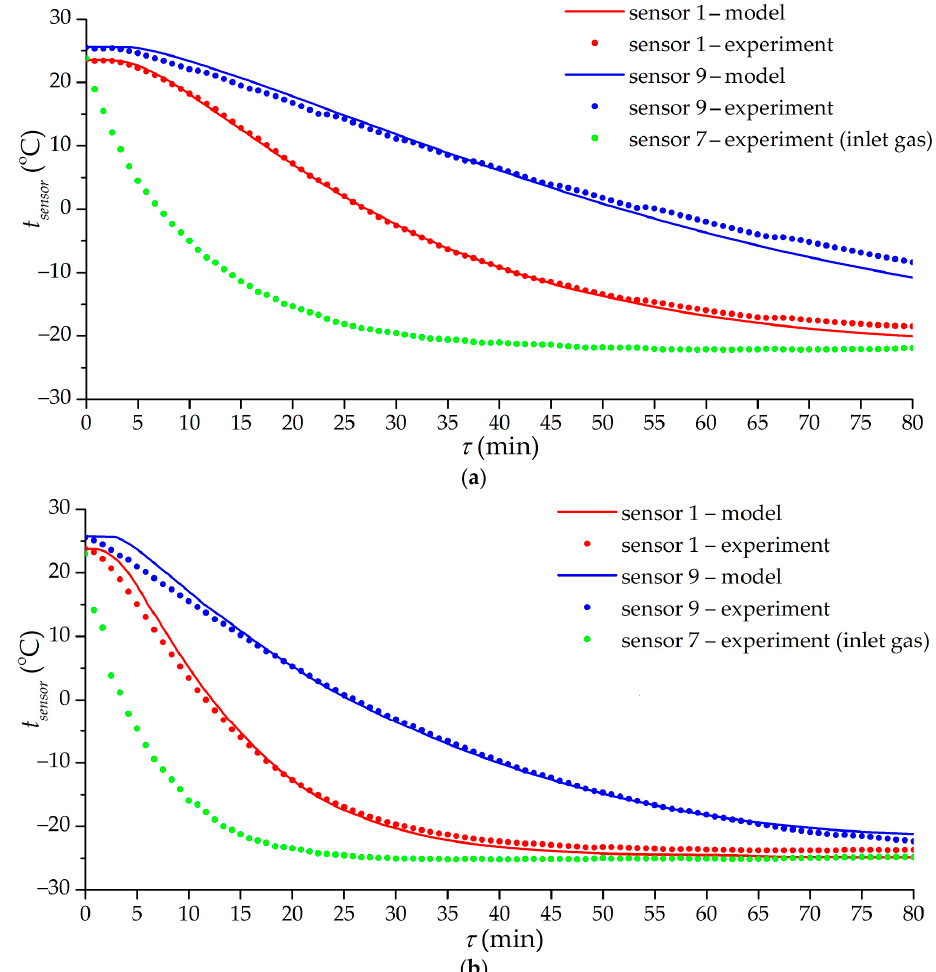
Figure 11. Time dependence of the temperature of sensors 1, 7, and 9 according to the results of experiments 8 ( a ) and 11 ( b ) and mathematical modeling. Lines are the results of mathematical modeling. Dots are experimental values.